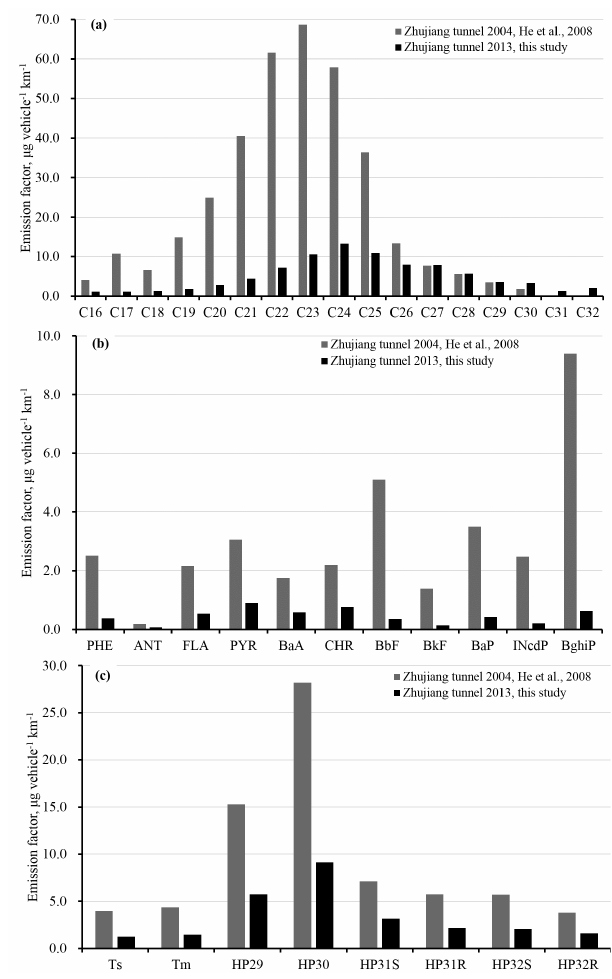
Figure 4. Comparison of organic compounds emissions in Zhujiang tunnel sampling in 2004 and